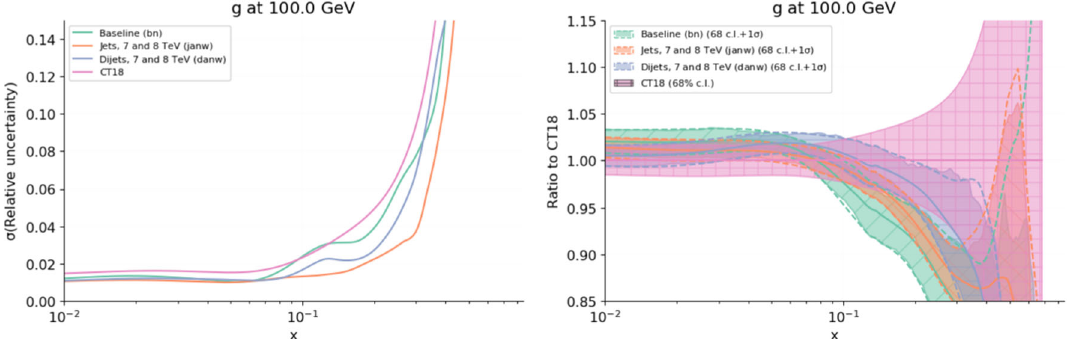
Fig. 17 Same as Fig. 7, but now comparing the baseline (#bn) to the fits with all single-inclusive jet (#janw) and dijet data (#danw) of Fig. 16. All results are shown as a ratio to the CT18 fit (also shown for